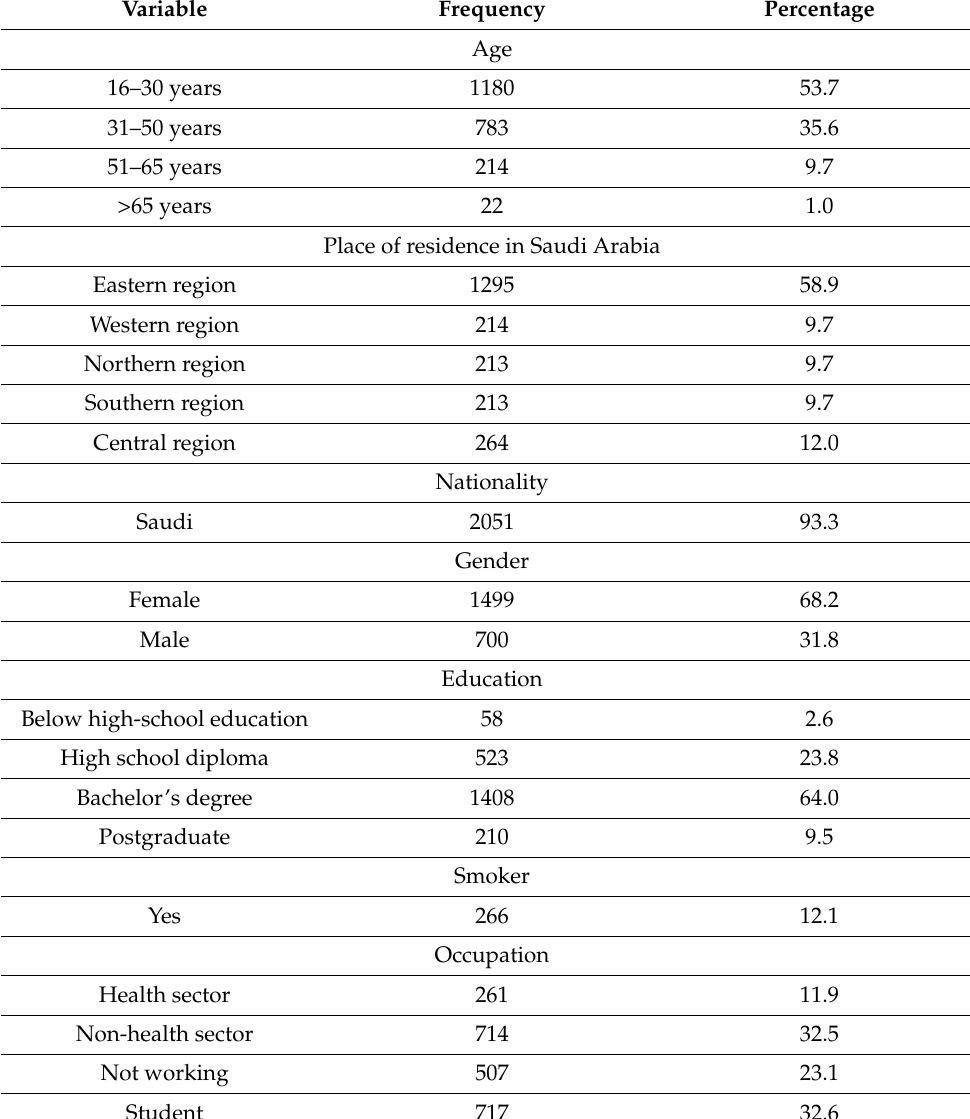
Table 1. Participants’ demographic